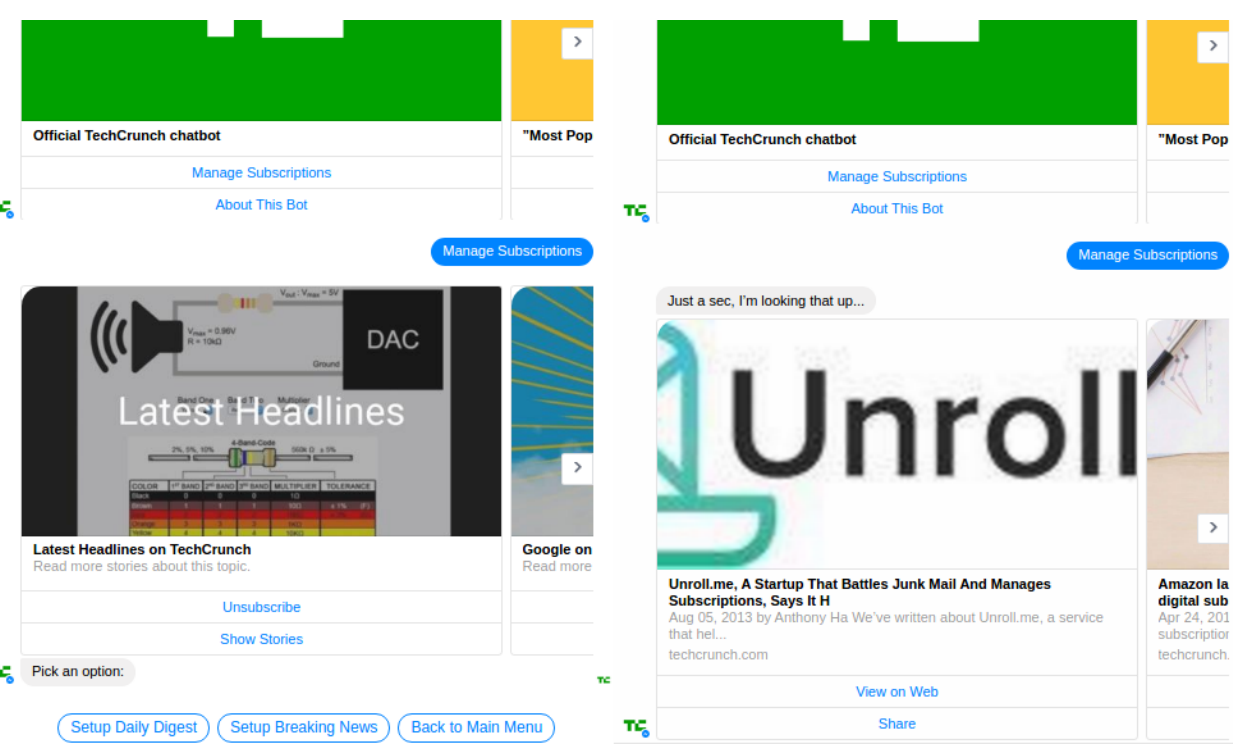
Fig. 13. Left image shows TechCrunch’s feedback when users choose the suggestion ‘Manage Subscriptions’ presented; Right image shows TechCrunch’s feedback when users type ‘Manage